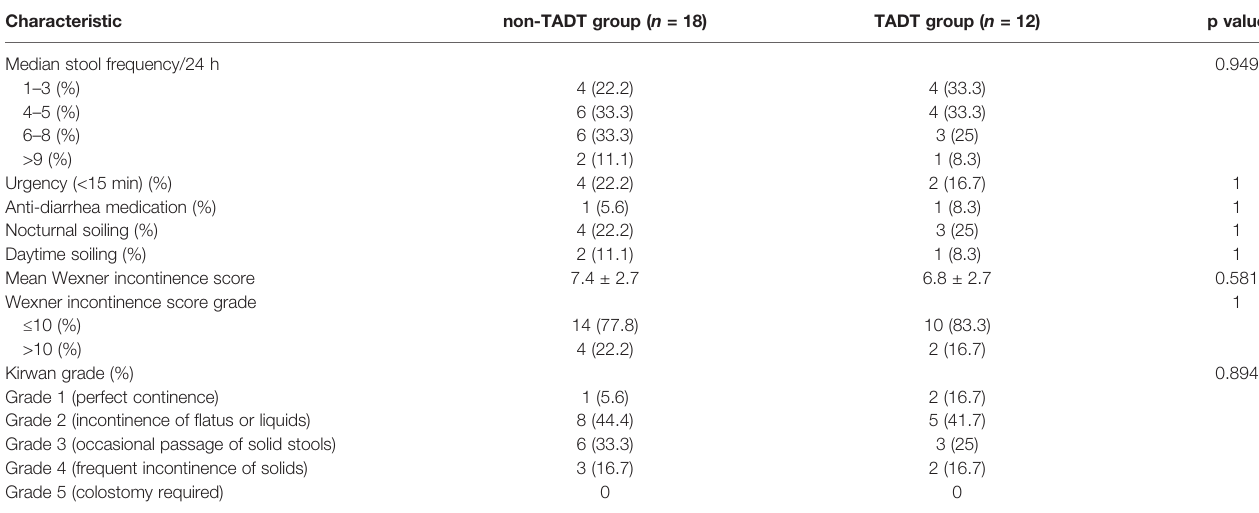
Values are means ± standard deviations or medians with ranges in parentheses.